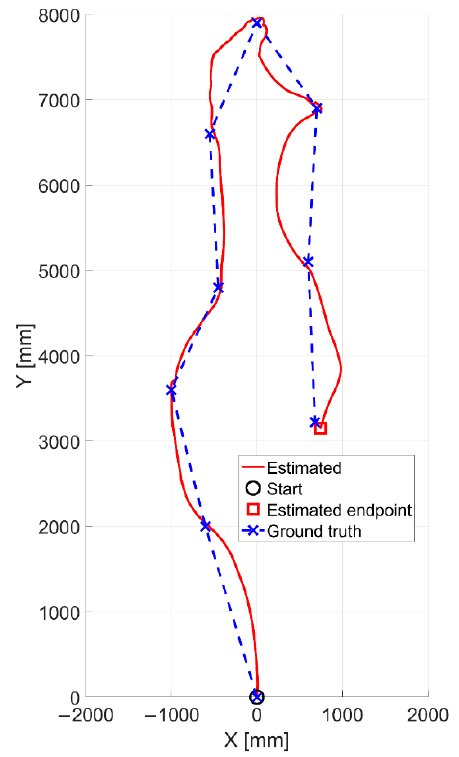
Figure 14. Estimated position of optical sensor (in red) and corresponding ground truth (blue markers).